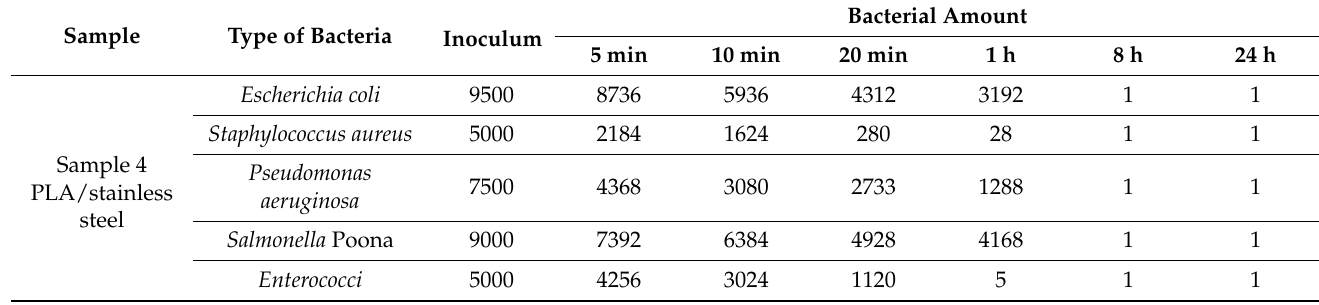
Table 5. Bacterial count on PLA/stainless steel 17-4 sheet over different time intervals.